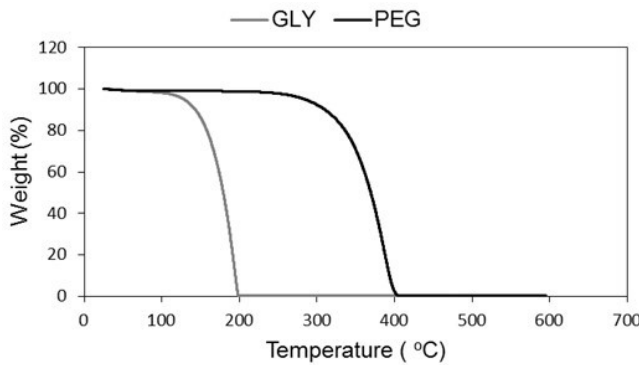
Figure 1. Thermogravimetric analysis of the additives glycerol (GLY) and poly(ethylene glycol) (PEG).